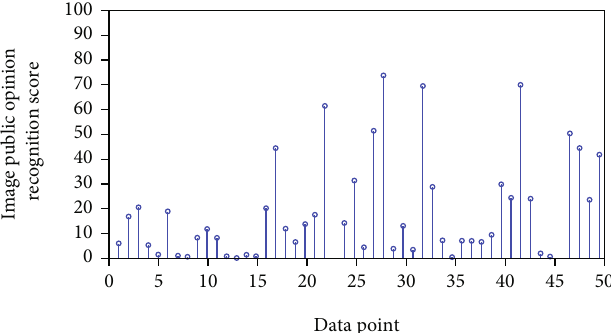
Figure 7: Evaluation of the e ff ect of network image public opinion recognition on di ff erent data points.